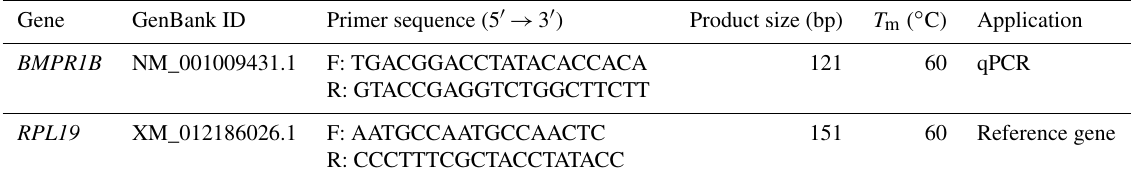
Table 2. Primers used in the present study. Gene GenBank ID Primer sequence (5 (cid:48) → 3 (cid:48) ) Product size (bp) T m ( ◦